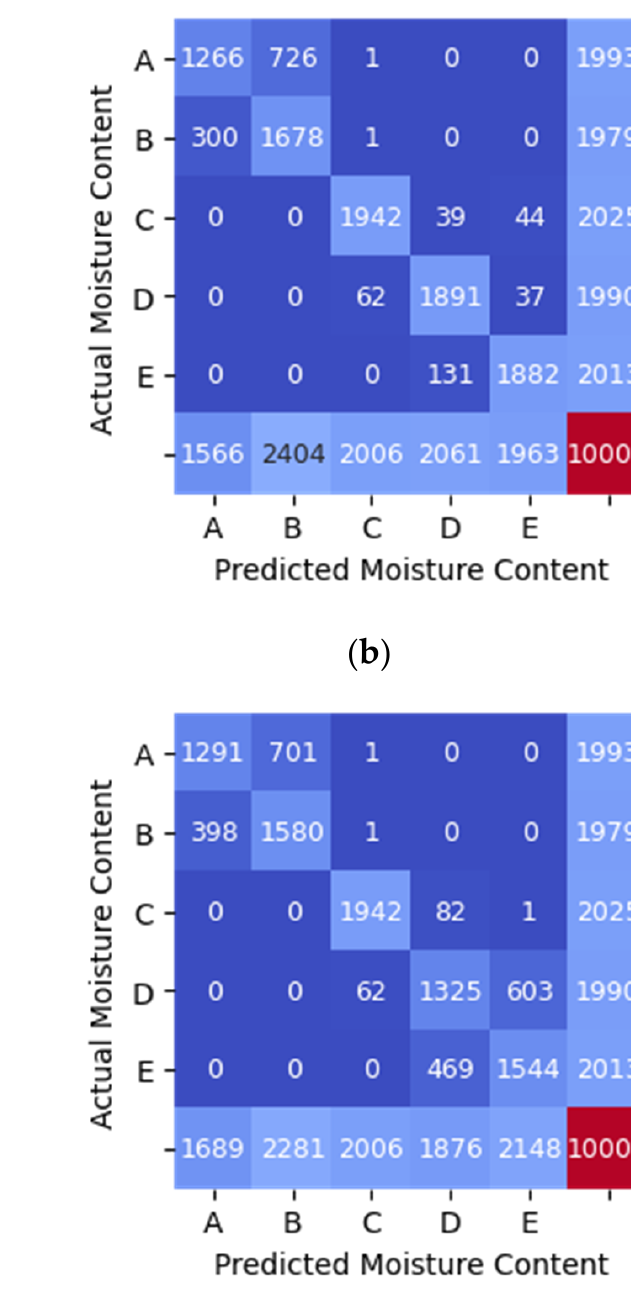
Table 9 indicated that the KNN is not suitable for classifying the moisture content as the MAE, MSE and RMSE values are high with the MAE for KNN (RSSI_WSN) and KNN (RFID_TAG1) being the highest at 9.70. From the three features (RSSI_WSN, RSSI_TAG1 and RSSI_TAG2), RSSI_TAG1 data is not suitable for determining the moisture content of rice. The SVM, Random Forest and MLP can be used to classify the moisture content. However, this study found that, based on the MAE, MSE and RMSE, the Random Forest model using the two features (RSSI_WSN and RSSI_TAG2) is the best classification model where the MAE, MSE and RMSE are 0.05, 0.28, and 0.52, respectively.